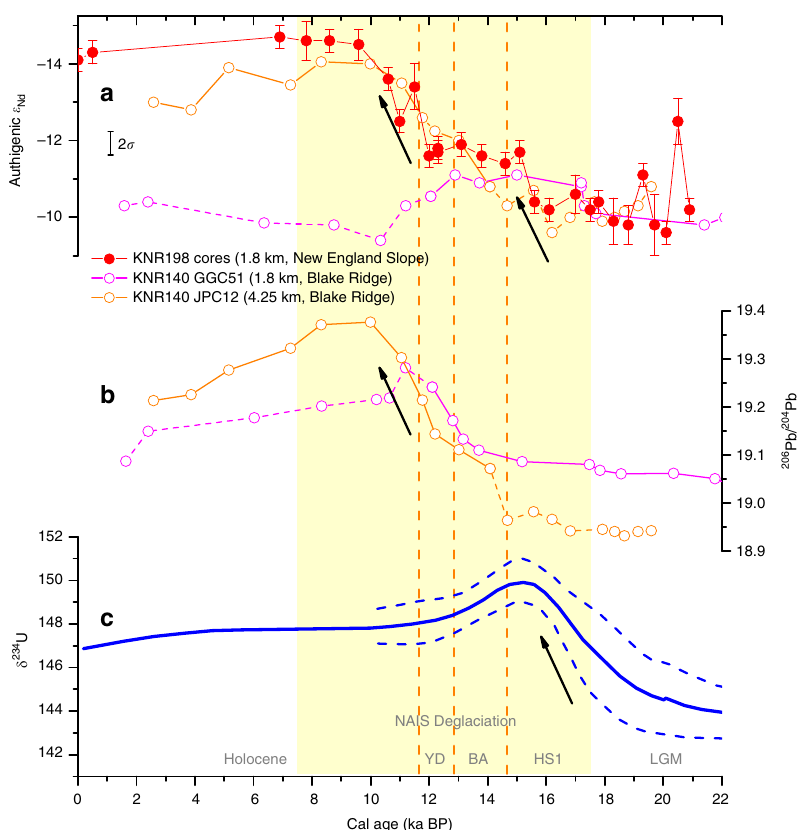
Fig. 4 Reconstructed isotope composition variability of Nd, Pb and U in seawater from the North Atlantic. a Authigenic ε Nd based on foraminifera from our study (with 2 σ error) and sediment leachates from two Blake Ridge cores (with their 2 σ errors represented by the black error bar) 17 . b Authigenic 206 Pb/ 204 Pb based on sediment leachates from the two Blake Ridge cores 36 , with error bars smaller than the symbols. For a and b , the data in each core for the interval that are most likely in fl uenced by sediment redistribution 17 are connected by a dashed line. c Reconstructed δ 234 U of the upper (0.7 – 2.1 km) tropical North Atlantic, with the mean value shown as a solid line and 2 σ error as dashed lines 45 . YD: Younger Dryas; BA: Bølling – Allerød; HS1: Heinrich Stadial 1; LGM: Last Glacial Maximum. Black arrows in this fi gure denote potential in fl uences of weathering fl uxes related to NAIS deglaciation: the increased subglacial melting and detritus discharge during HS1 and the enhanced chemical weathering of the Canadian Shield in the early